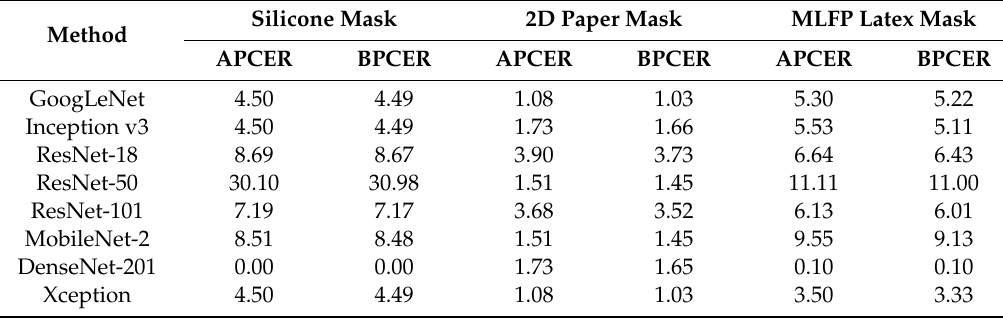
Table 9. Results of cross-material validation 1